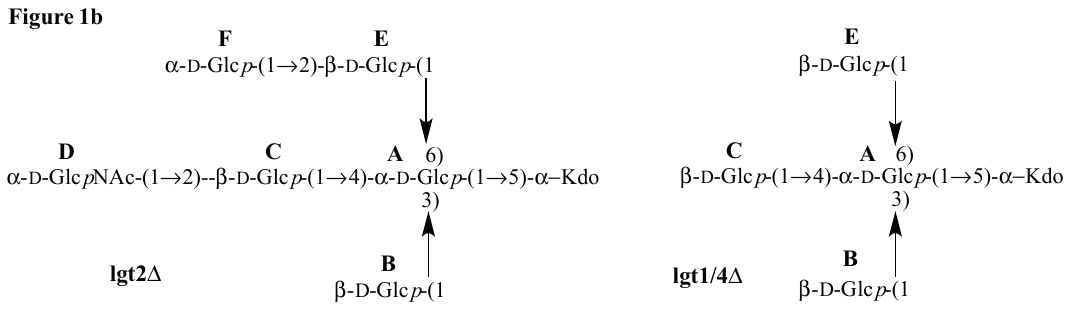
Figure 1. Structures of ( a ) wild-type serotypes A , B and C Moraxella catarrhalis LOS (OS highlighted (sugar labeling according to Lycknert et al . [20]); and ( b ) serotype A lgt2 Δ and lgt1/4 Δ